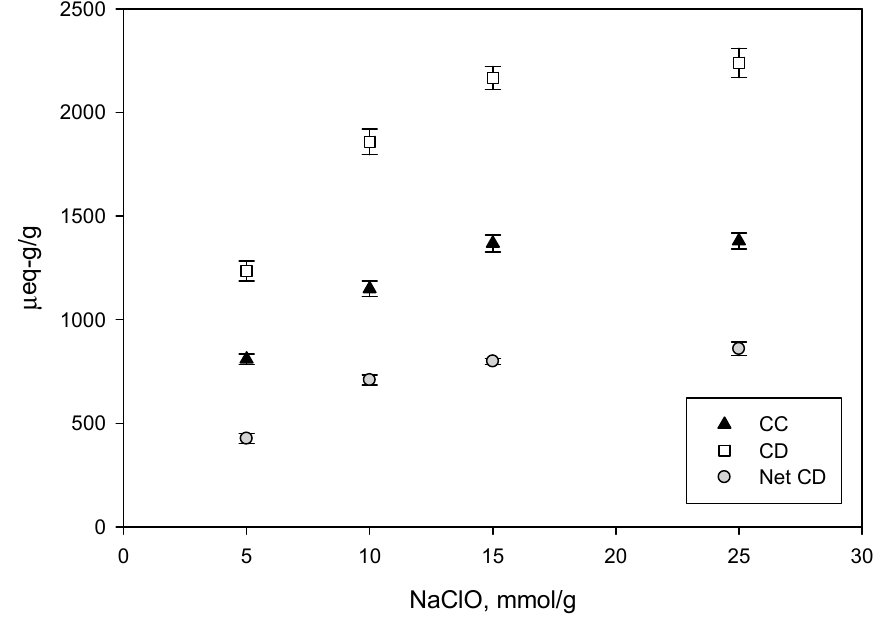
Figure 2. Evolution of the carboxyl content (CC) (black), cationic demand (CD) (white) and Net CD (grey) with increasing amounts of NaClO.